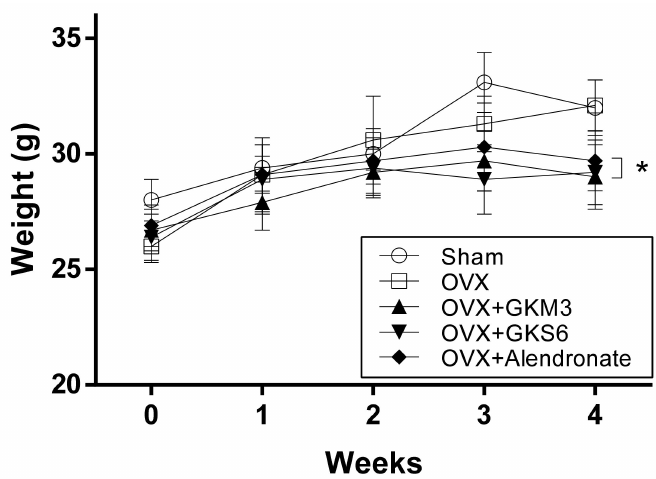
Figure 1. Body weight changes of mice in di ff erent groups. * p < 0.05 compared with ovariectomized (OVX) mice.